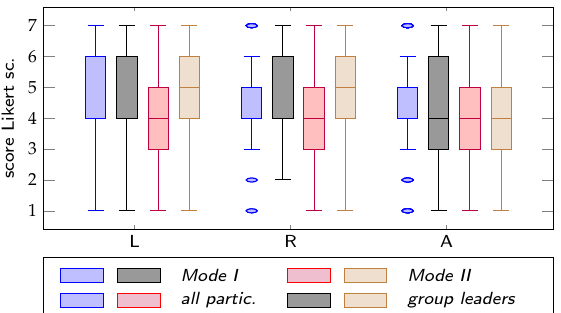
Figure 7. Response scores for tests with learning paths for the variables like (L), recommend (R) and play again (A).